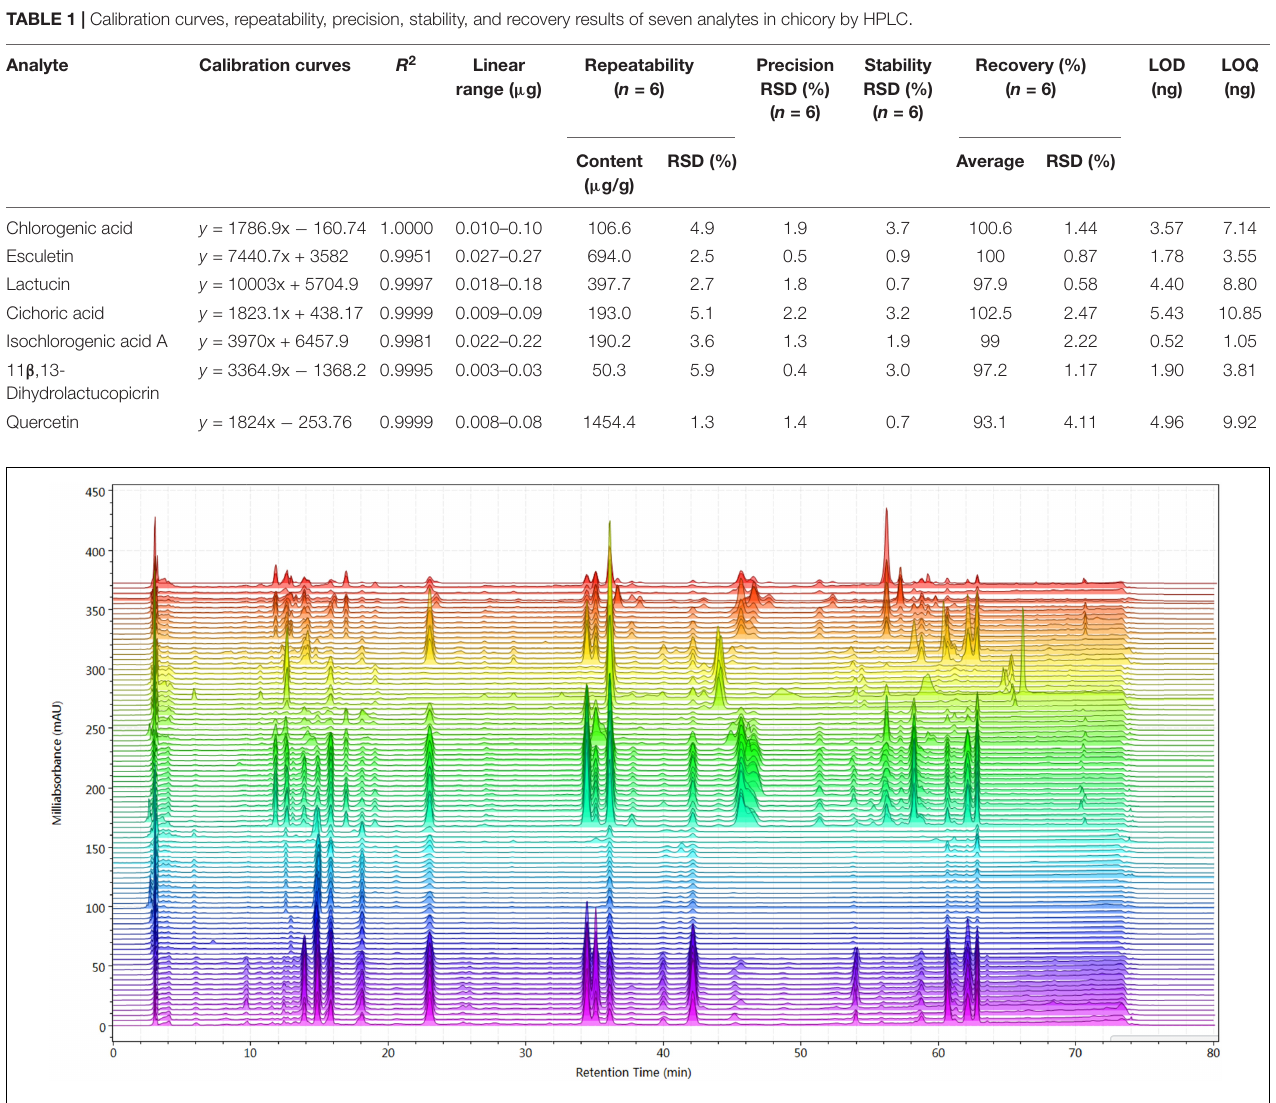
FIGURE 2 | Chromatographic profile of chicory (above-ground parts and